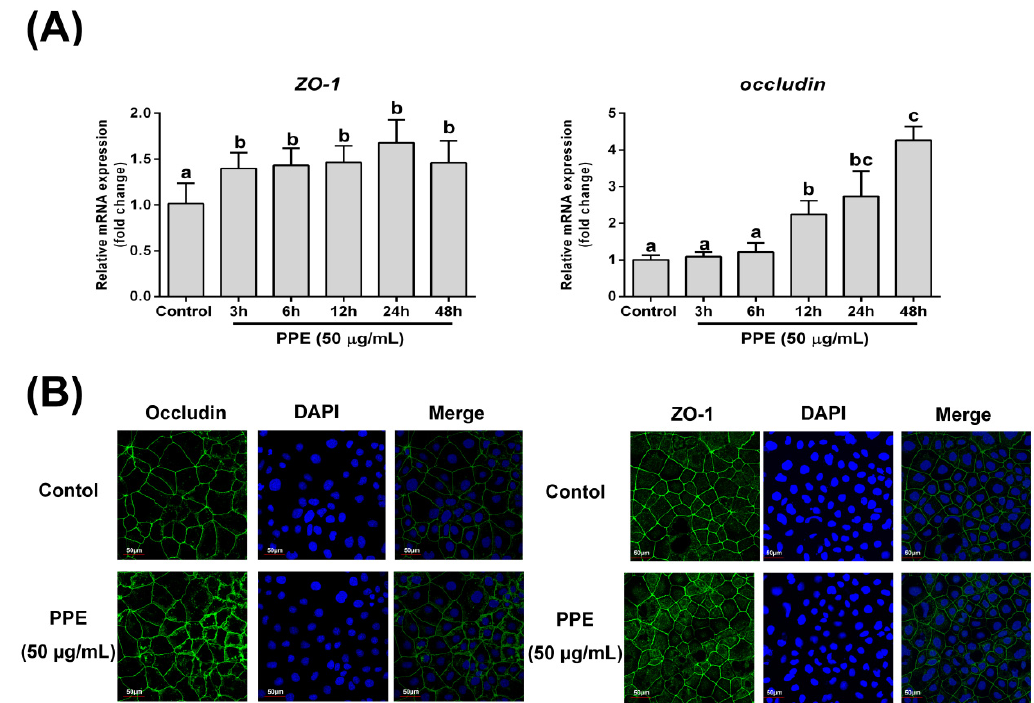
Figure 2. Effects of PPE treatment on gene expression, the distribution of tight junction proteins (ZO ‐ 1 and occludin) in Caco ‐ 2 cells. ( A ) Effect of PPE treatment on the mRNA expression of ZO ‐ 1 and occludin. Caco ‐ 2 cells were grown to confluence on 6 ‐ well plates and treated with PPE (50 μ g/mL) for the indicated periods. ZO ‐ 1 and occludin mRNA expression levels were analyzed by qRT ‐ PCR. Data are presented as means ± SD ( n = 3). Means sharing the same letter are not significantly different from each other ( p < 0.05); ( B ) Confocal microscopy images of immuno ‐ stained tight junction proteins in confluent Caco ‐ 2 cells untreated or treated with PPE (50 μ g/mL) for 48 h. Representative confocal microscopy images were obtained by fluorescent microscopy from three independent experiments after immunofluorescence staining of ZO ‐ 1 and occludin. 4 ′ ,6 ‐ Diamidino ‐ 2 ‐ phenylindole (DAPI) staining was performed to identify nuclei.